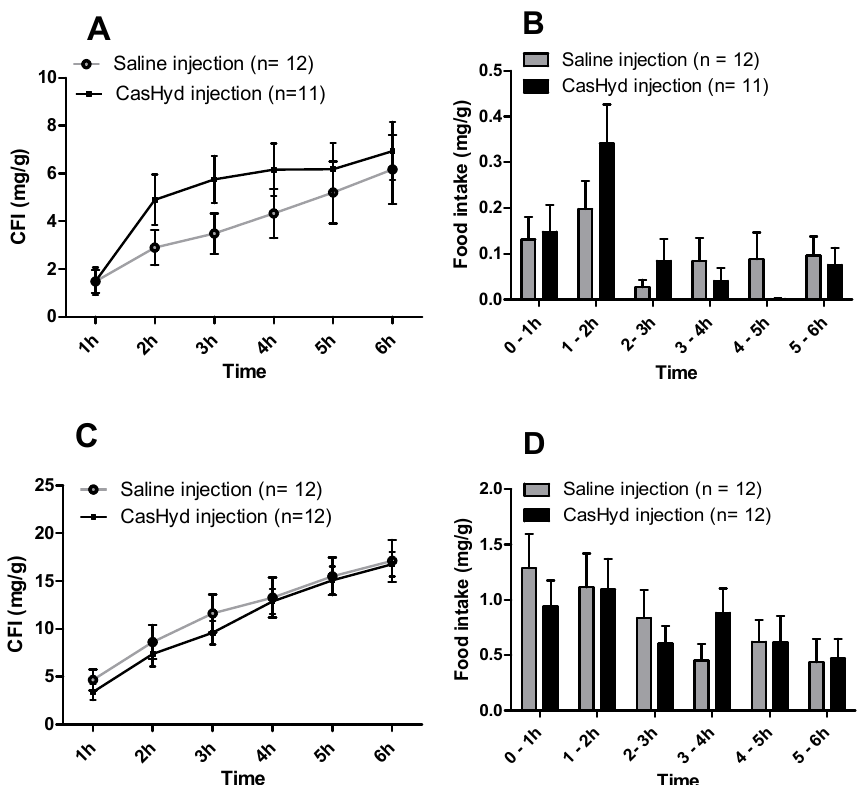
Figure 7. Cumulative food intake following intraperitoneal administration of dairy-derived peptide hydrolysate. Cumulative food intake (CFI) (regular chow) intake in male ( A ) and female ( C ) Sprague-Dawley rats was determined following intraperitoneal injection with 50 mg · kg − 1 body weight of CasHyd over 6 h. The food intake per time bin is also illustrated for males ( B ) and females ( D ). Data presented as mean ± SEM.